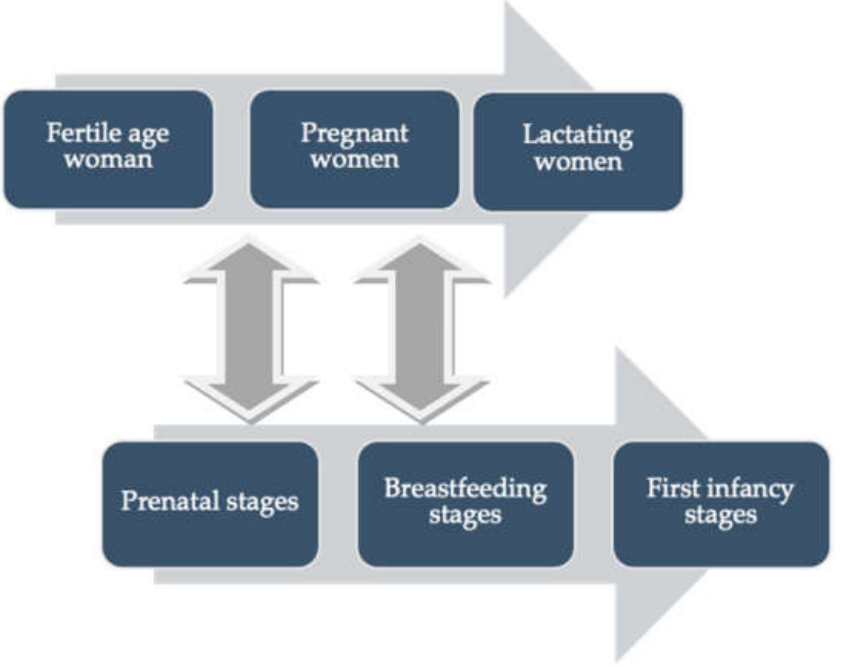
Figure 2 . Stages of vulnerability related to the exposure to pesticides in women and children